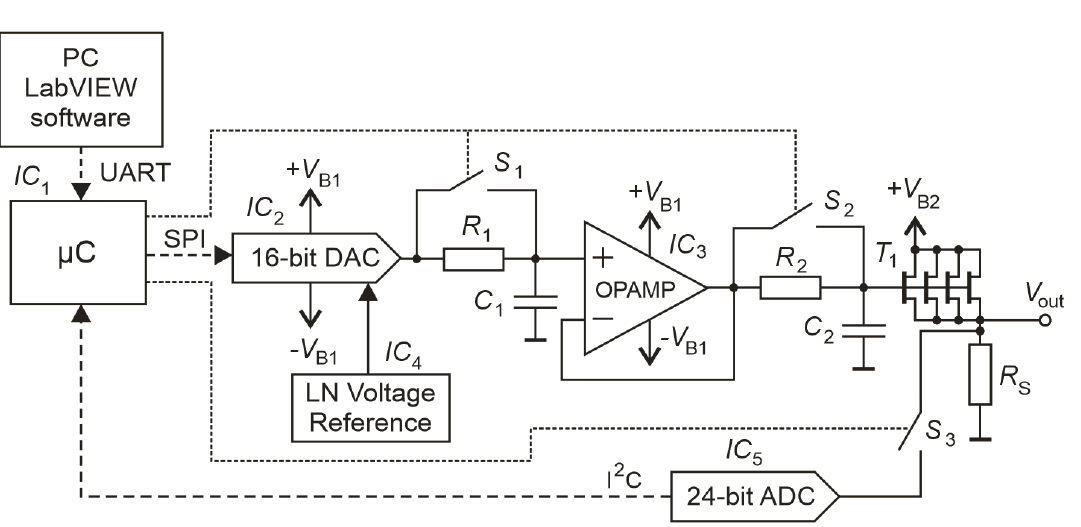
Figure 1. Schematic diagram of the proposed low voltage source.